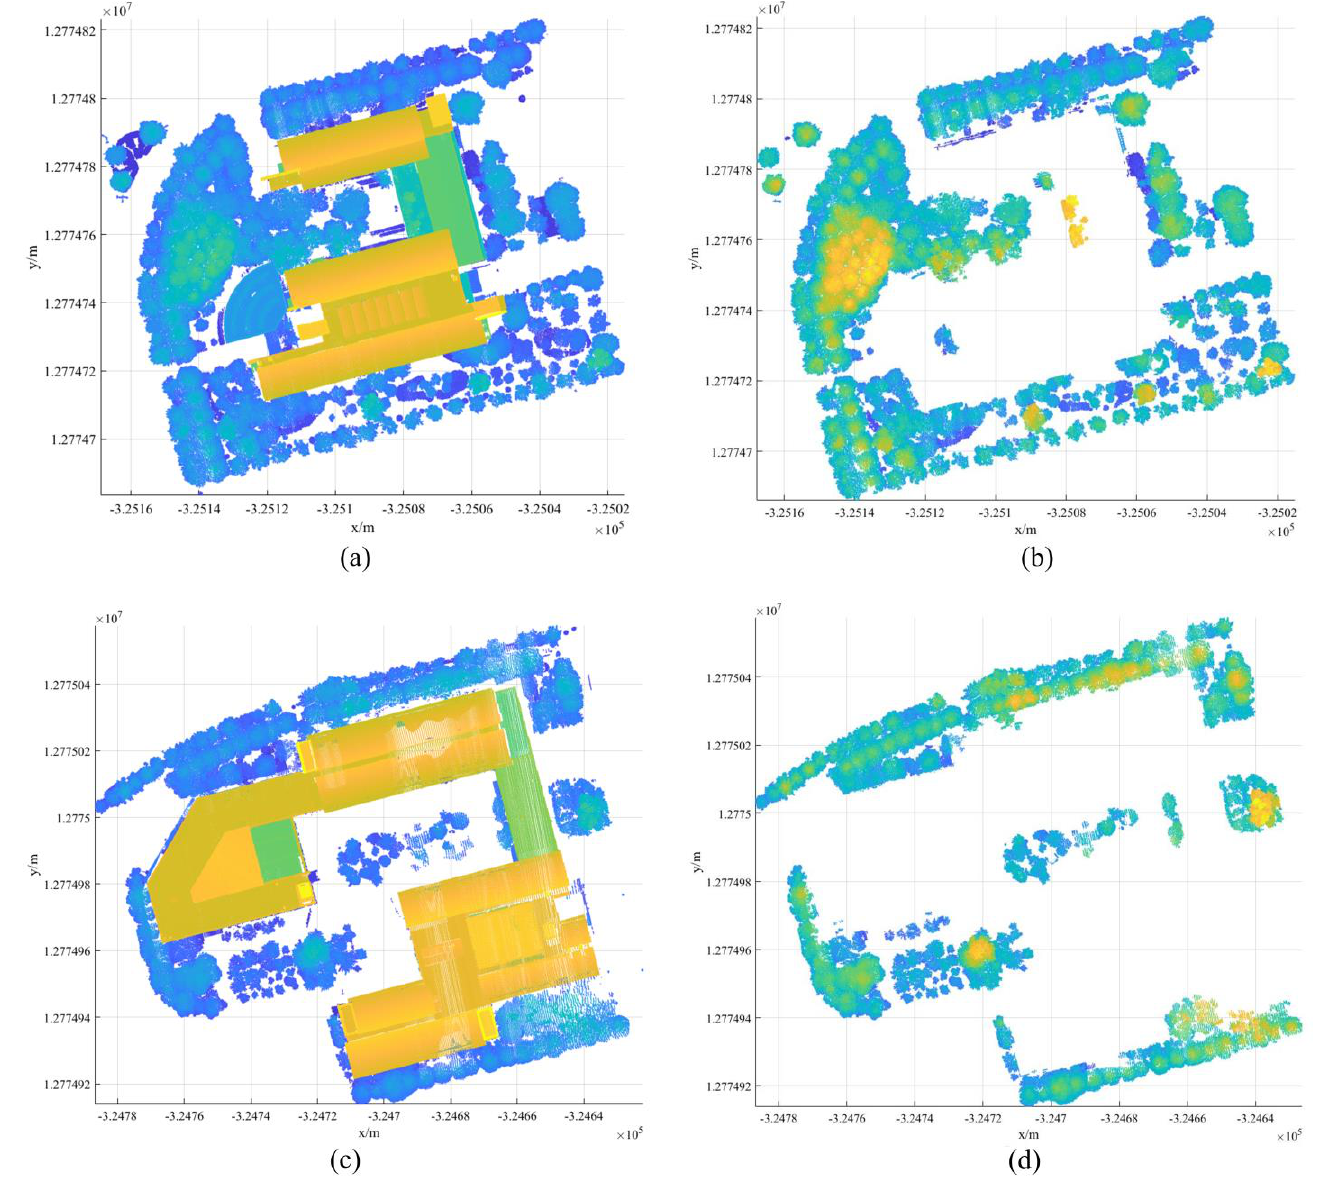
Figure 13. The final accurate extraction results of vegetation in two plots. ( a ) Original data of plot 1; ( b ) Final vegetation extraction result of plot 1; ( c ) Original data of plot 2; ( d ) Final vegetation extraction result of plot 2.